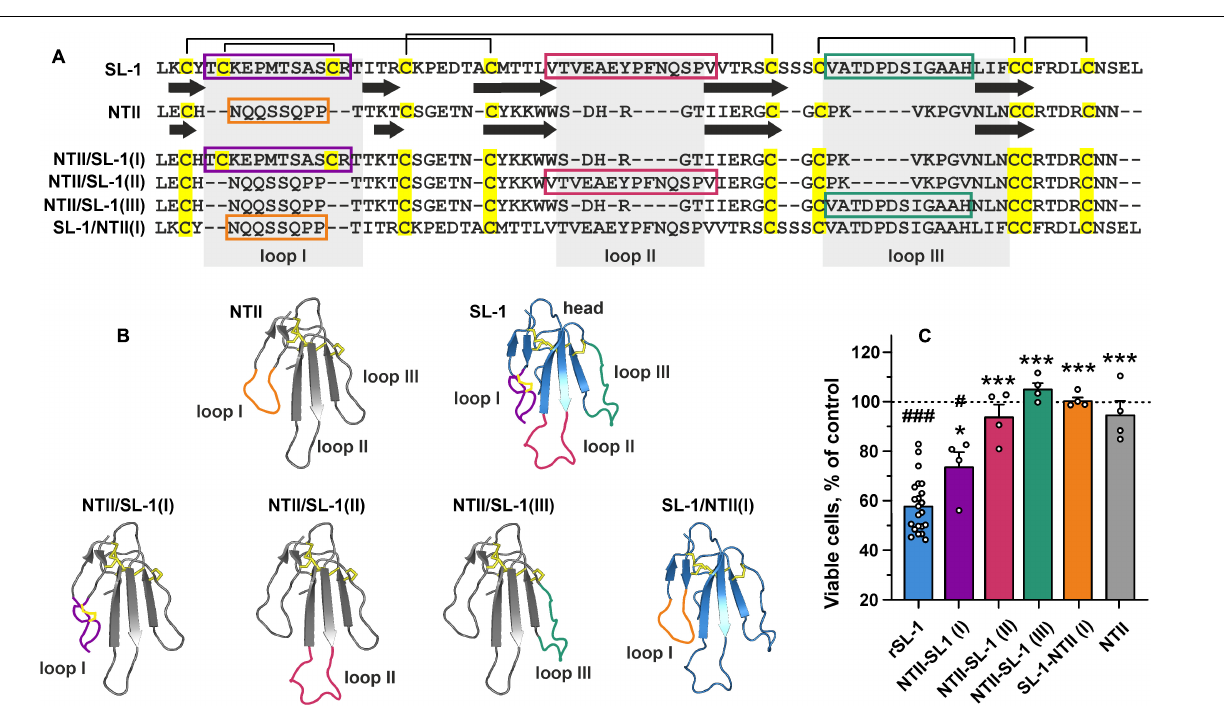
FIGURE 4 | Design and study of antiproliferative activity of chimeric NTII/SL-1 and SL-1/NTII proteins. (A) Amino acid sequence alignment of SLURP-1, NTII, and chimeras. Cys residues are shown by yellow. Disulfide bonds are shown by brackets. The β -strands are designated by arrows. Sequences of the grafted loops are highlighted by color frames. (B) Schemes depicting the chimeric NTII/SL-1 and SL-1/NTII proteins. Color coding is the same as on the panel (A) . (C) Antiproliferative activity of the chimeric proteins in A549 cells according to WST-1 test. Cells were incubated during 48 h with 1 µ M of the proteins. Data are presented as % of control (untreated cells, dashed line) ± SEM ( n = 4–22). # ( p < 0.05) and ### ( p < 0.001) indicate significant difference from the control by one-sample t -test. * ( p < 0.05) and *** ( p < 0.001) indicate significant difference from the “rSLURP-1” group by one-way ANOVA/Dunnett’s